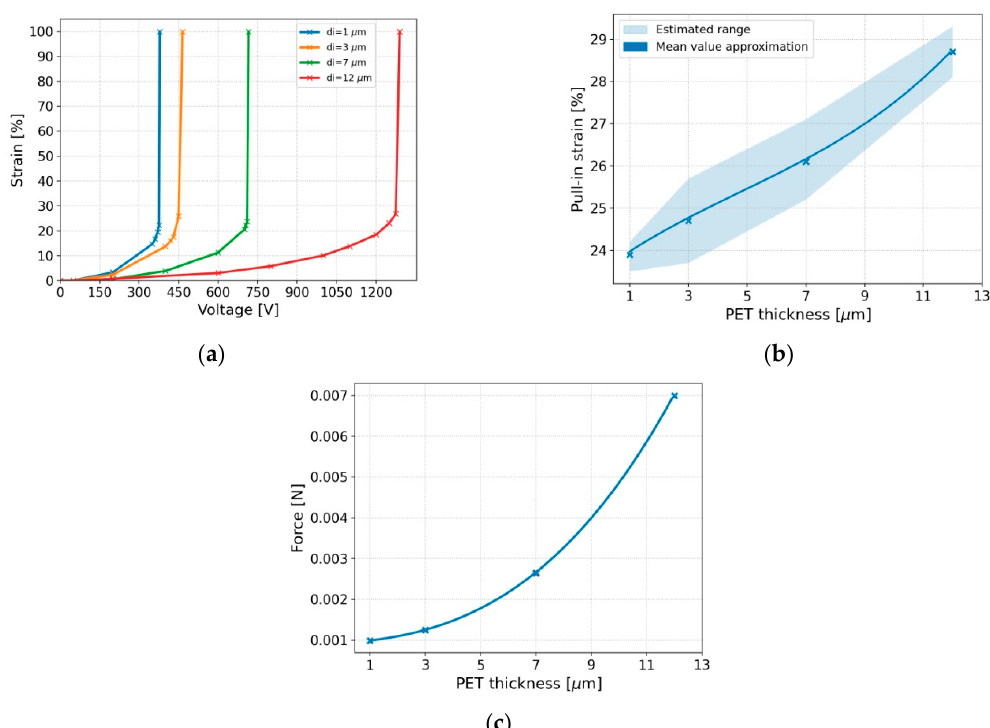
Figure 8. ( a ) Strain-voltage characteristics for 4 thicknesses of PET layer of the actuator; ( b ) Pull-in strain-thickness characteristic of the actuator; ( c ) Force-thickness characteristic of the actuator.